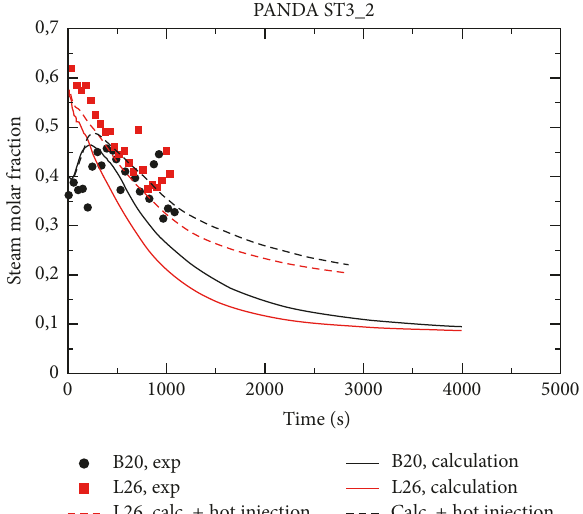
Figure 30: Vapor molar fraction in